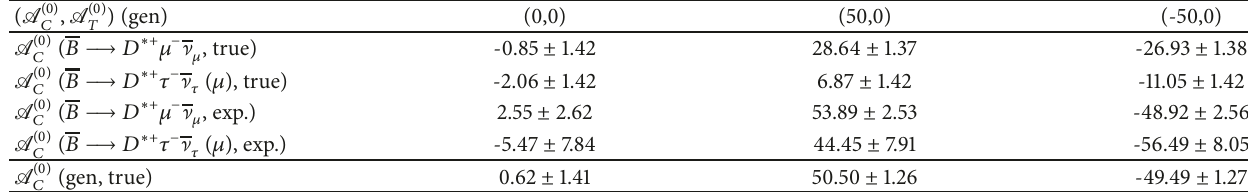
Table 3: Measured A (0) 𝐶 (in %) fitting the angular distribution equation (19) or the polynomial expansions equation (20) to the 𝐵 󳨀→ 𝐷 ∗+ 𝑙 − ] 𝑙 test samples for varying generated values; the last row reports the ideal sensitivity obtained from a toy sample generated from the true angular distribution with the same number of events of the test sample, fitted with the same